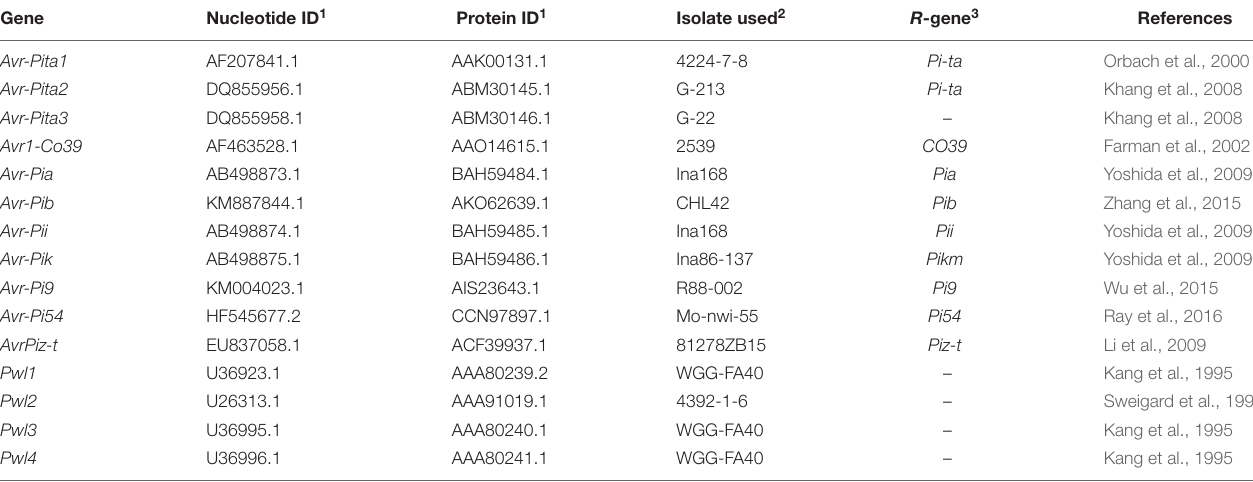
TABLE 1 | The M. oryzae AVR and host-specificity genes analyzed in this